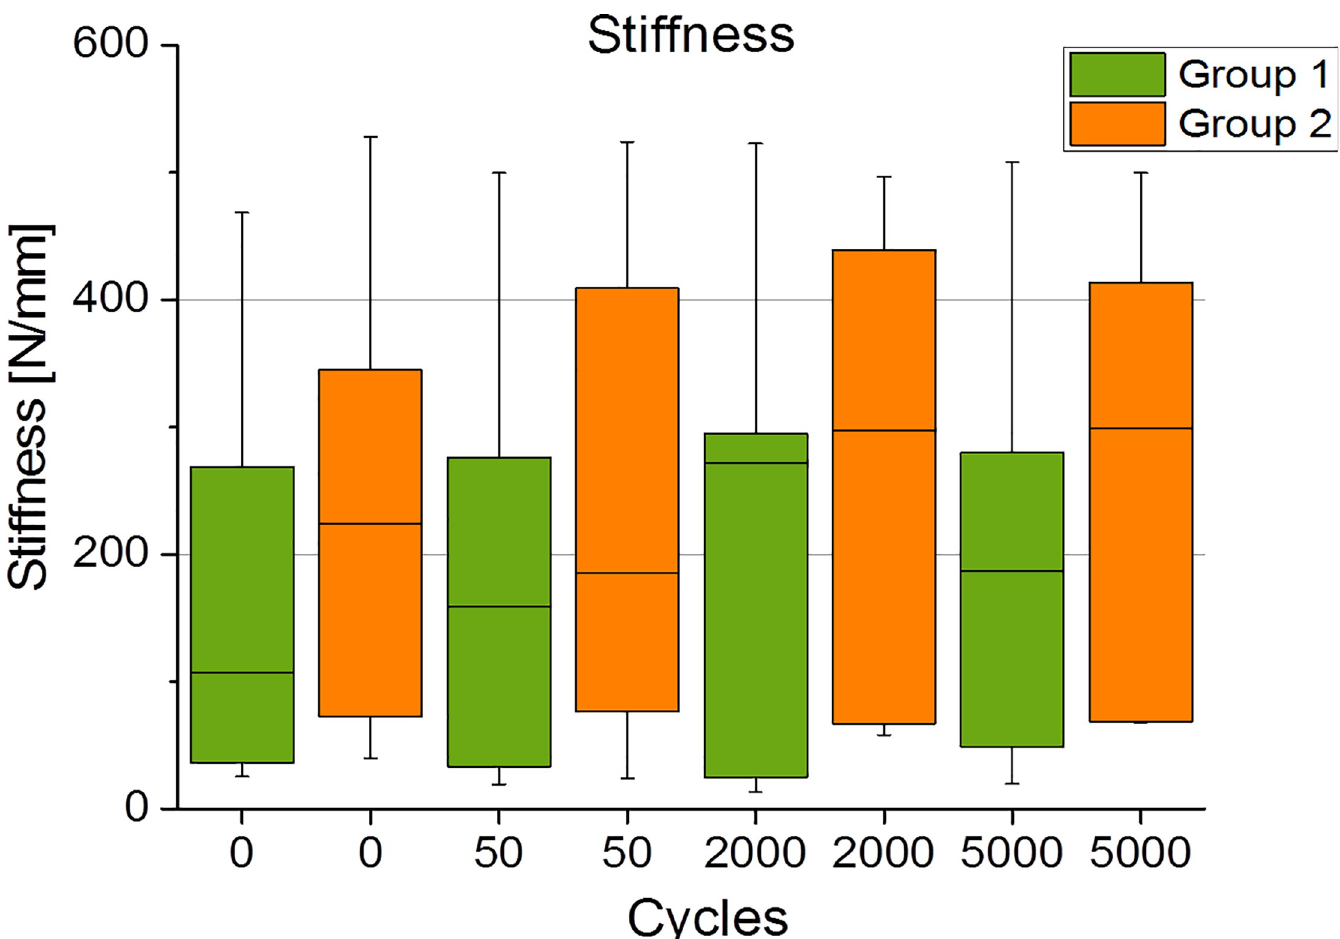
Fig 3. Boxplot of the stiffness after 0, 50, 2000 and 5000